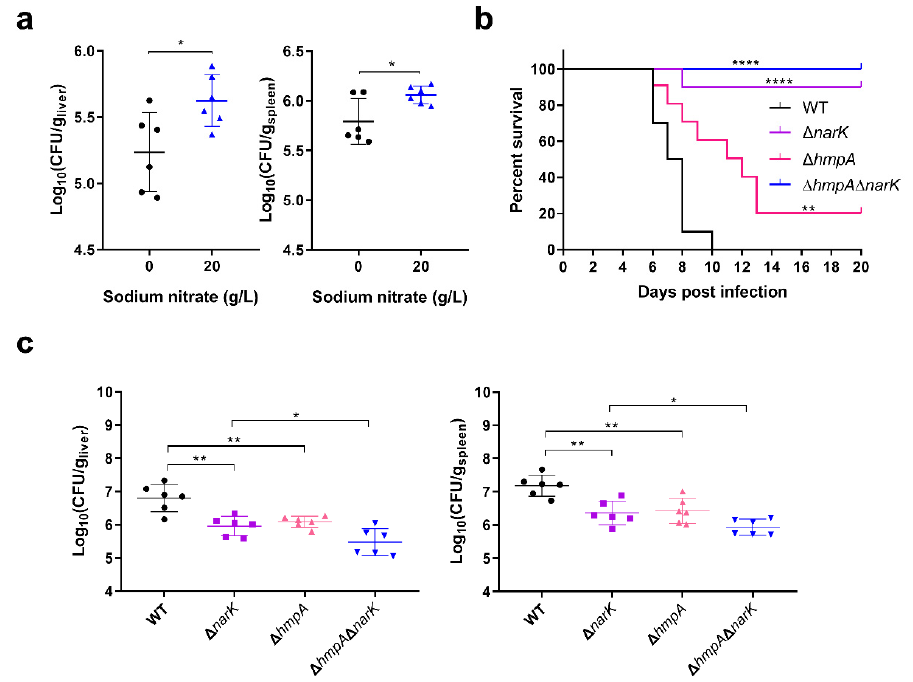
Figure 3. Nitrate utilization promotes S. Typhimurium systemic infection in the mice. ( a ) Drinking water containing 20 g/L of sodium nitrate was provided for mice from 3 days before i.p. infection to the end of the experiment. Meanwhile, the drinking water without the addition of sodium nitrate was used as control. Bacterial burdens of liver and spleen in infected mice were assessed at day 5 post-infection. n = 6 mice/group. ( b ) Survival curves for mice infected i.p. with the S. Typhimurium WT, Δ narK, Δ hmpA , or Δ hmpA Δ narK, n = 10 mice/group. ( c ) Liver and spleen bacterial burdens in mice infected with the S. Typhimurium WT, Δ narK, Δ hmpA , or Δ hmpA Δ narK at day 5 post-infection . n = 6 mice/group. ( a – c ) Data were combined from two independent experiments and are presented as mean ± SD. p values were determined using Mann–Whitney U test ( a , c ) or log-rank Mantel–Cox test ( b ) (* p < 0.05; ** p < 0.05; **** p < 0.0001).